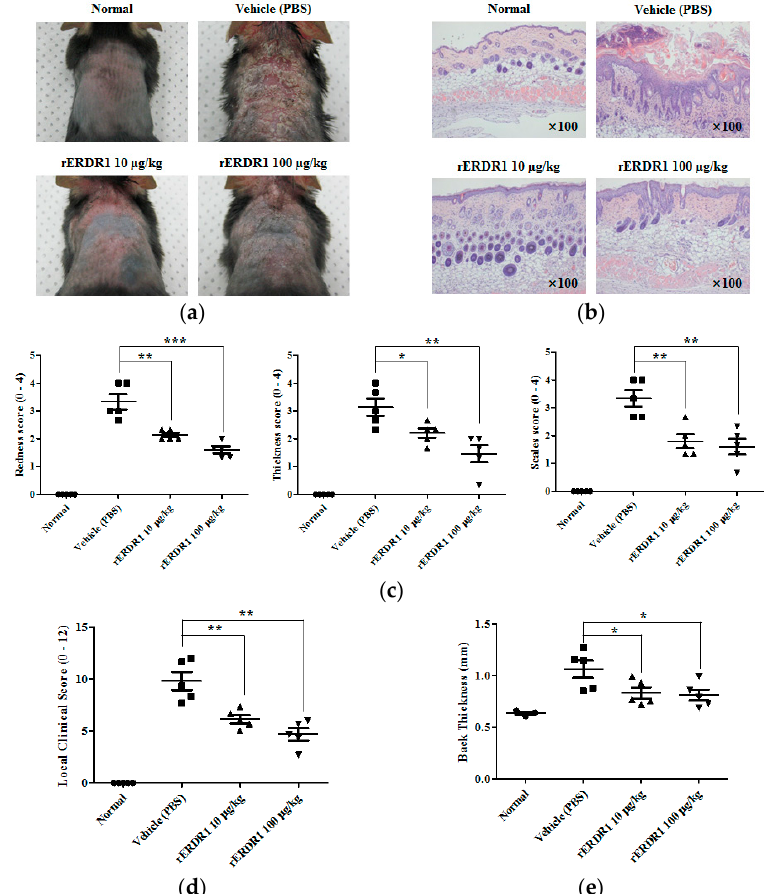
Figure 1. Recombinant erythroid differentiation regulator 1 (ERDR1) exerts therapeutic effects on psoriasis-like skin inflammation. ( a ) Photos showing redness and scales of psoriatic lesional skin induced by topical application of Aldara cream (5% imiquimod) on the shaved back skin of female 6-week-old C57BL/6J mice treated by 10 or 100 μ g/kg intraperitoneally injected recombinant ERDR1 (rERDR1) versus PBS vehicle control. Five mice were used for each group, experiments were repeated independently three times, and data shown represent one mouse from each group; ( b ) H&E staining of the lesional skin shows decreased inflammatory infiltration, acanthosis, parakeratosis, and severe desquamation in rERDR1-injected mice compared to controls (×100 magnification); ( c ) Severities of redness, thickness, and scales of psoriasis-like skin lesions were evaluated from 0 to 4 (0, none; 1, mild; 2, moderate; 3, severe; and 4, very severe). Scoring was based on the severity of redness, thickness, and scales. Data are reported as mean ± standard deviation (SD). All values were analyzed using an unpaired Student’s t -test. * p < 0.05, ** p < 0.01, *** p < 0.0005; ( d ) The overall local clinical score was totaled from the sum of each category, including redness, thickness, and scales. Data are reported as mean ± SD. All values were analyzed using an unpaired Student’s t -test. ** p < 0.01; ( e ) Back skin thickness of the rERDR1-injected group vs. vehicle (PBS)-injected group, as measured using a thickness gauge. Data are reported as mean ± SD. All values were analyzed using an unpaired Student’s t -test. * p < 0.05. Data shown represent one of three independent experiments.